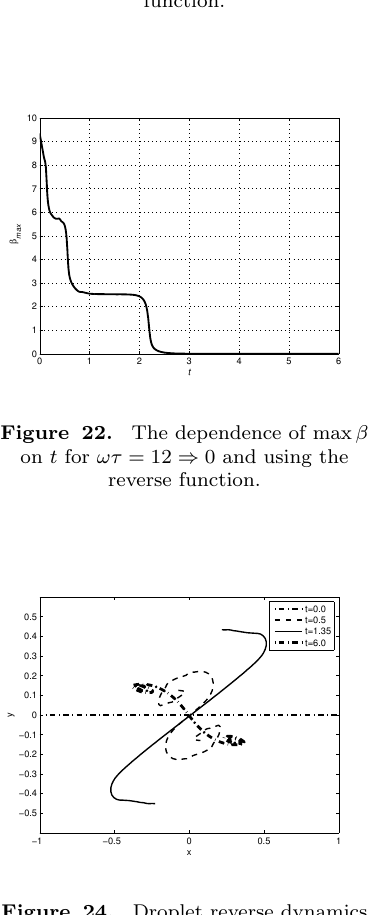
Figure 20. The dependence of max β on t for ωτ = 5 ⇒ 0 using reverse function.